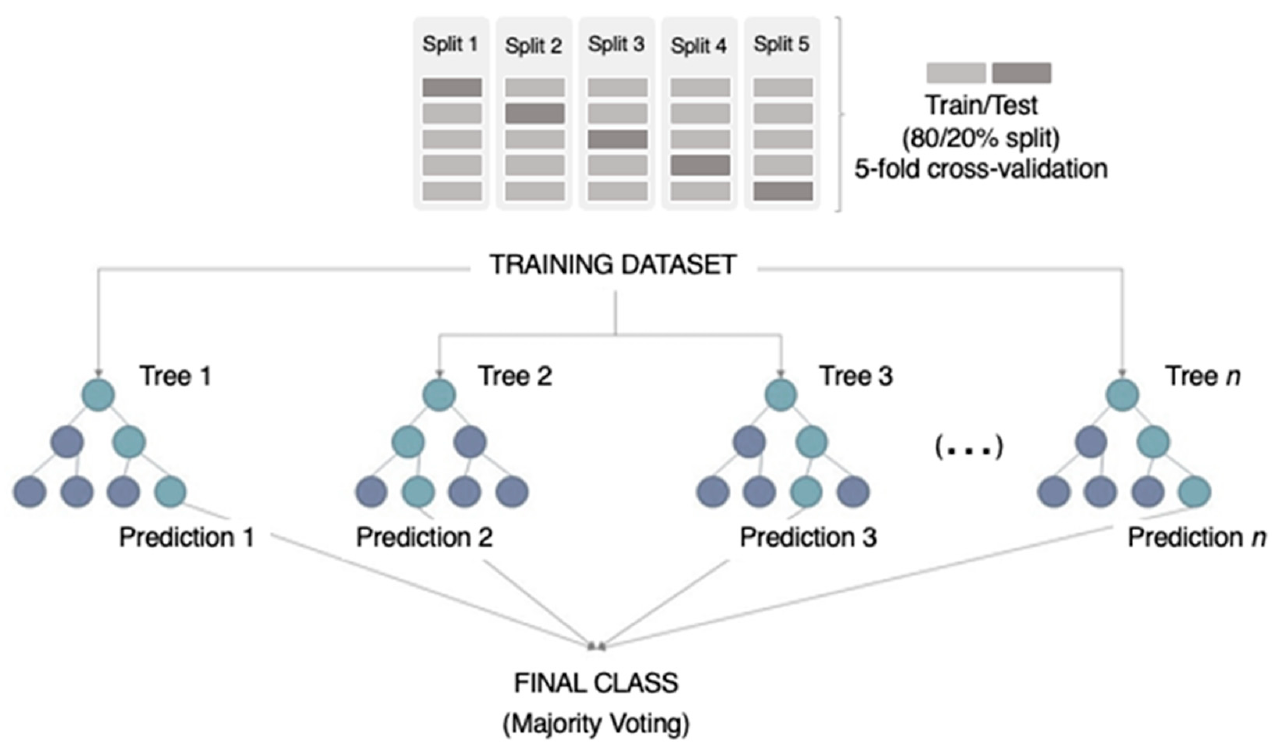
Figure 1. RF model architecture to forecast storm intensification to major hurricane. The model consists of an ensemble of trained decision trees with a feature importance function and a k-fold iterator. The input parameters are fed into the model, which outputs the feature importance vector about the relative importance of each predictor (see Figure 2) and 2-way class probabilities (TSs and MHs). The model performance is evaluated using Cohen’s kappa (k) and precision (p MH ) metrics.